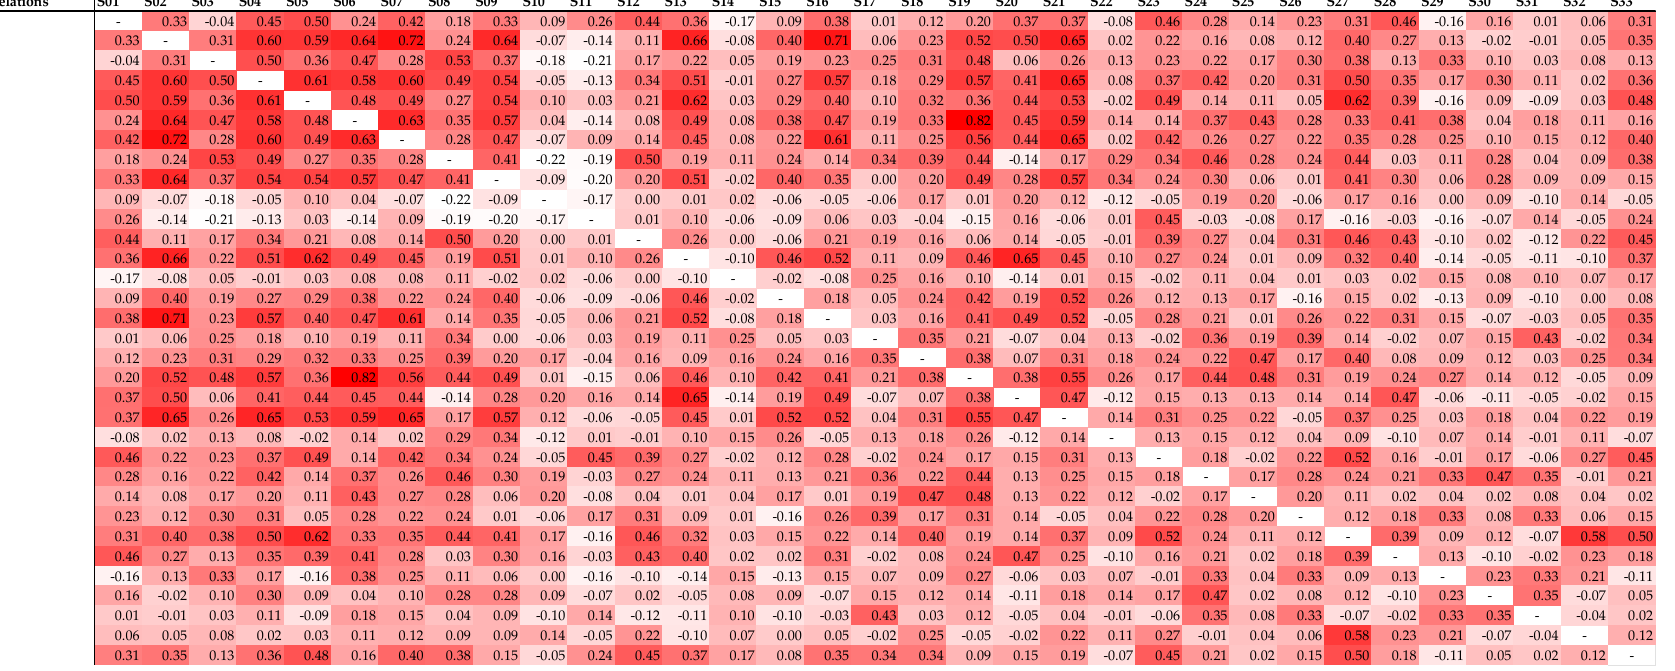
Figure 3. Cross-sector correlation coefficients for sectoral corporate defaults. Source: Author’s calculations. Note: Sectors are defined numerically for ease of presentation; see Appendix A for further details.